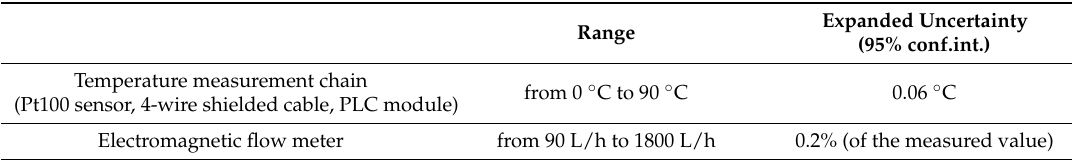
Table 1. Uncertainties of temperature and flow rate measurement chains for a particular heat meter assembly at the INRIM central heating system test facility.